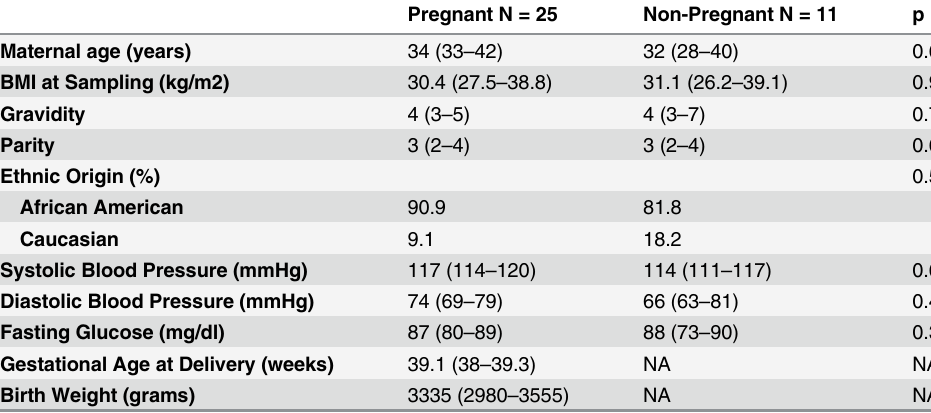
Table 1. Demographic and clinical